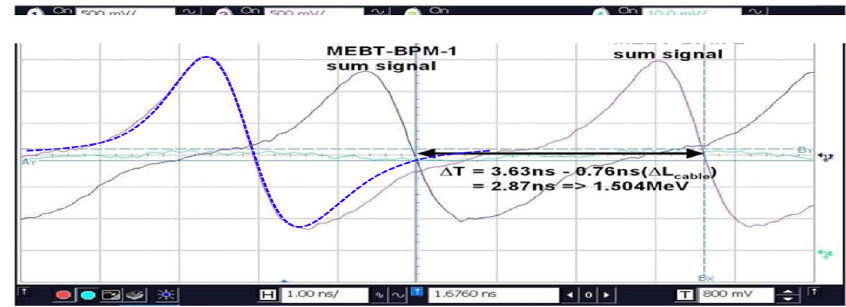
FIG. 5. (Color) Averaged sum of the four electrode signals obtained in the high energy section of SARAF. The dashed trace shows the response of a MATHEMATICA simulation using the same parameters as experimental conditions: a proton beam current of 4 mA at (cid:1) ¼ 0 : 06 , the bunch base length is (cid:1) 22 (cid:6) , the acceleration frequency is 176 MHz, and the inner pipe radius is 15